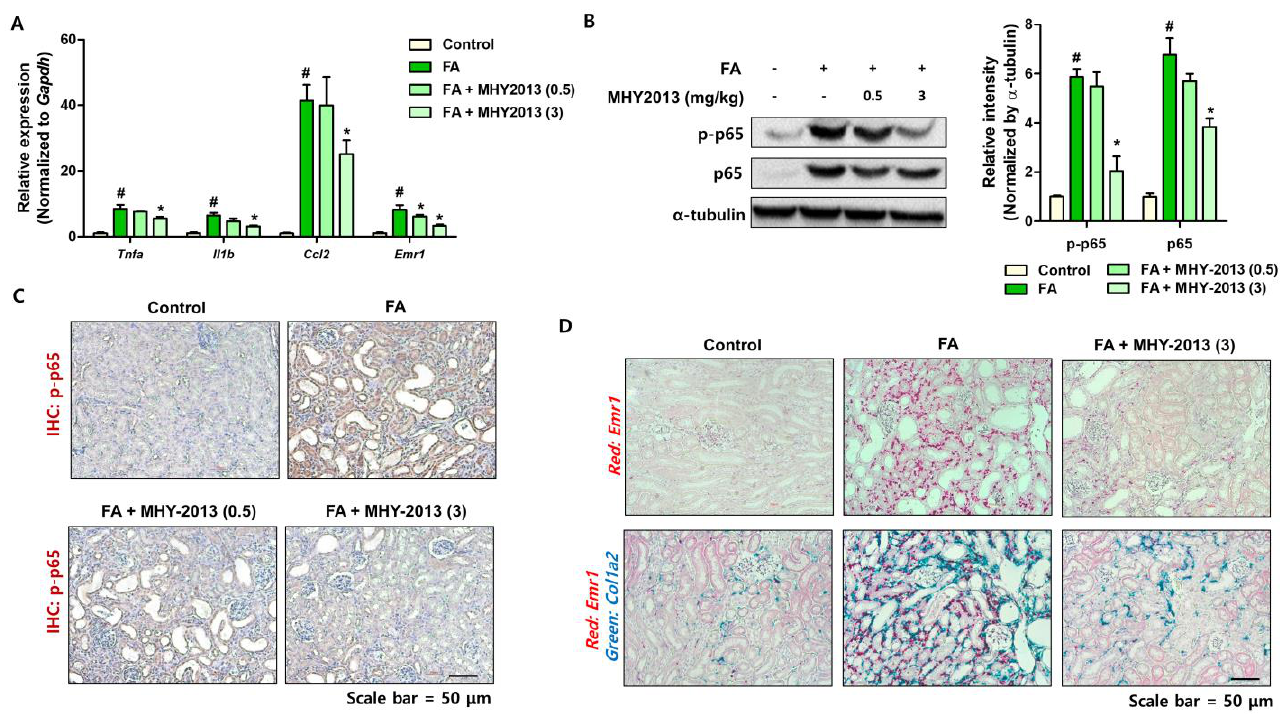
Figure 4. MHY2013 treatment reduces inflammation in FA model. ( A ) Relative mRNA levels of inflammation-related genes ( Tnfa , Il1b , Ccl2 , and Emr1 ) in FA-treated kidneys with or without MHY2013 treatment. # p < 0.05 vs. control groups. * p < 0.05 vs. FA group. ( B ) Protein levels of p-p65 and p65 were determined in FA-treated kidneys with or without MHY2013 treatment. α -tubulin was used as a loading control. Fold change difference in protein expression were determined with densitometric analysis. # p < 0.05 vs. control groups. * p < 0.05 vs. FA group. ( C ) Representative IHC images of p-p65 expression in FA-treated kidneys with or without MHY2013 treatment. ( D ) Representative in situ hybridization images detected with Emr1 (red) and Col1a2 (green) probes in FA-treated kidneys with or without MHY2013 treatment.